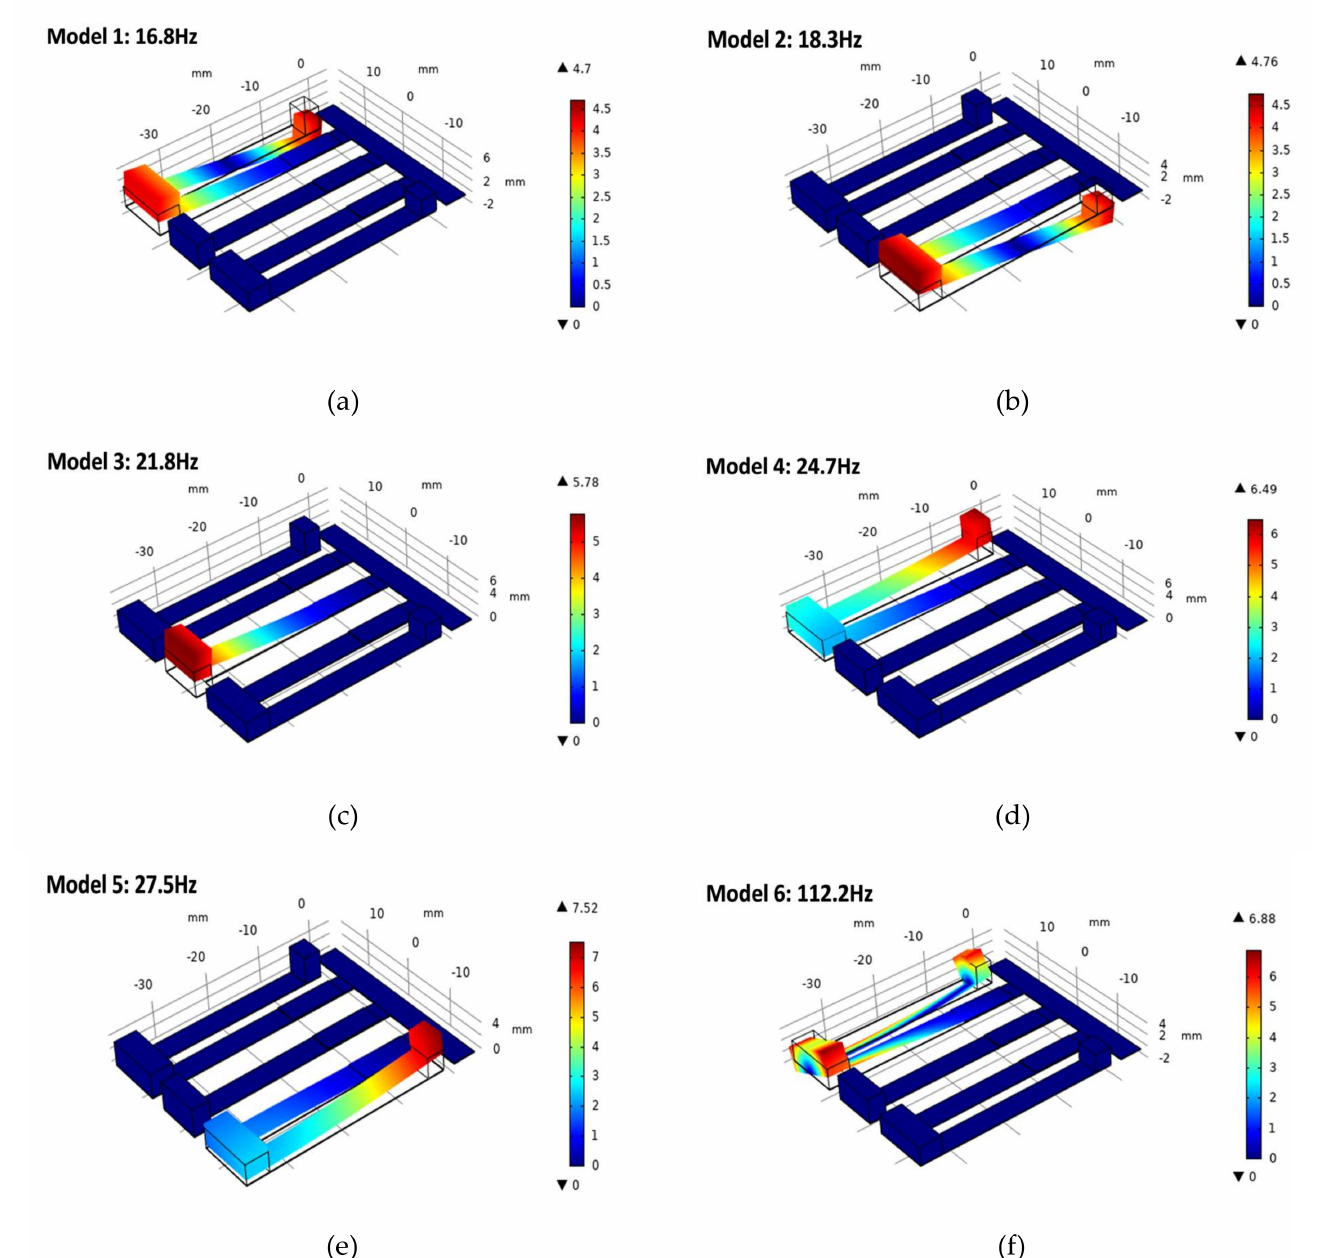
Figure 3. ( a – f ) Finite element simulation of multiple mode shapes of the proposed